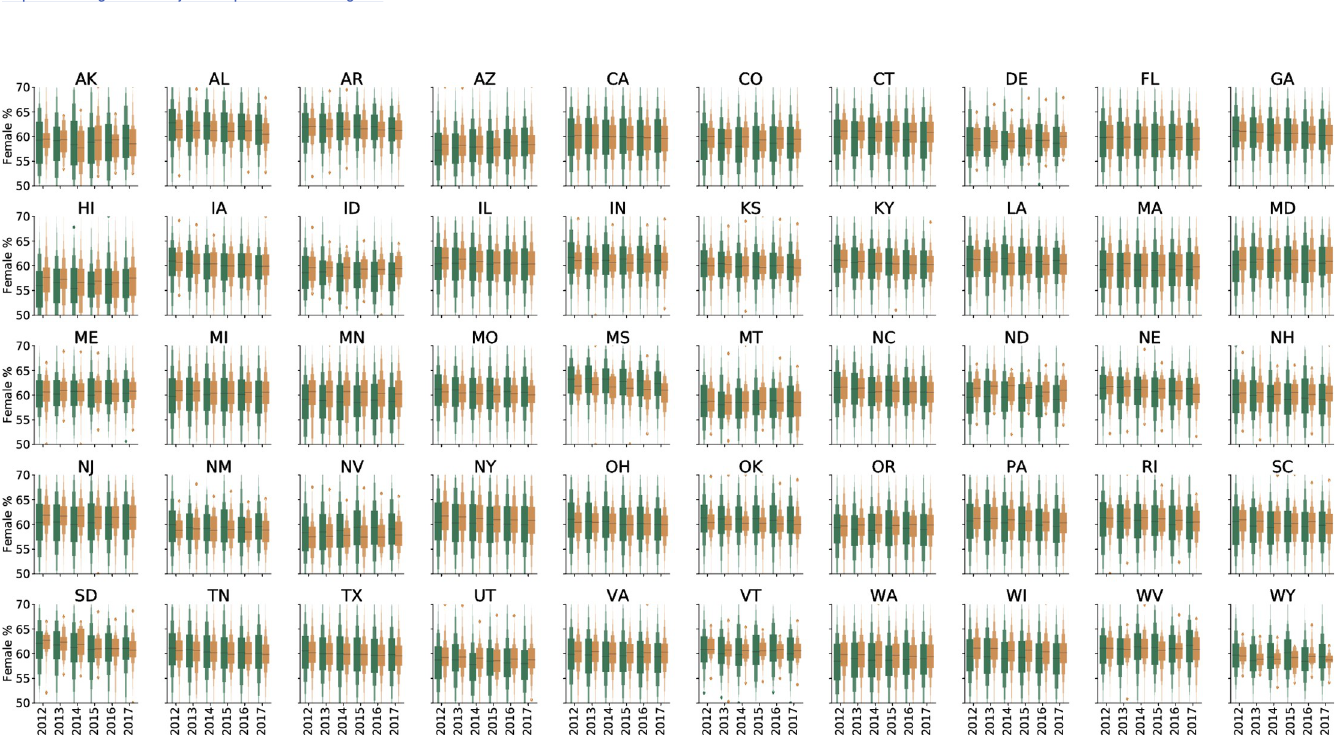
Fig 2. Letter-value plot for average percentage of female Medicare beneficiary population by state and eye provider type. Ophthalmologists are shown in yellow and optometrists are shown in green. The black line represents the median value.